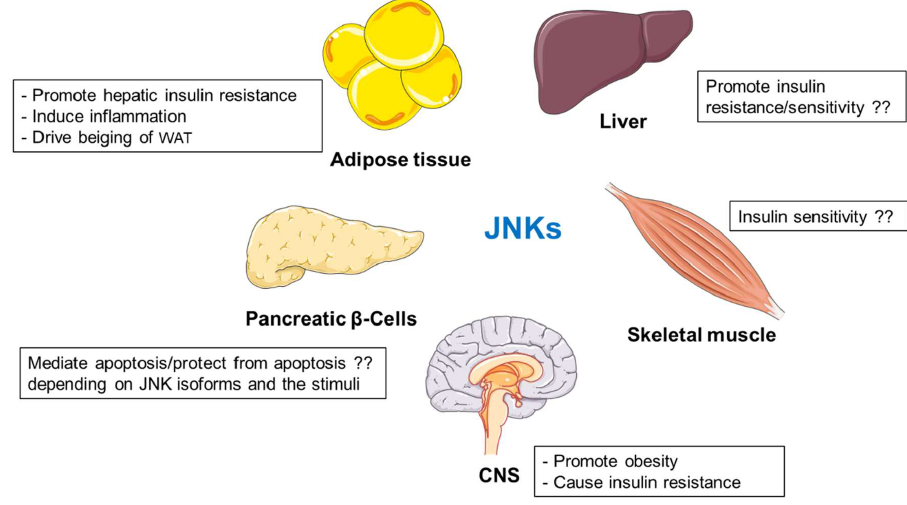
Figure 2. The role of JNKs in various tissues and organs.